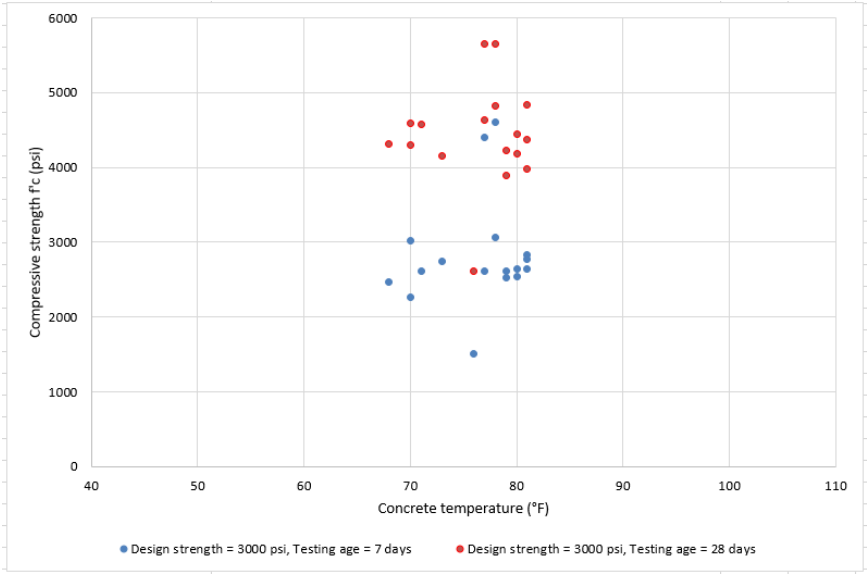
Figure 3. Relation between compressive strength and concrete temperature for a design strength of 3000 psi.